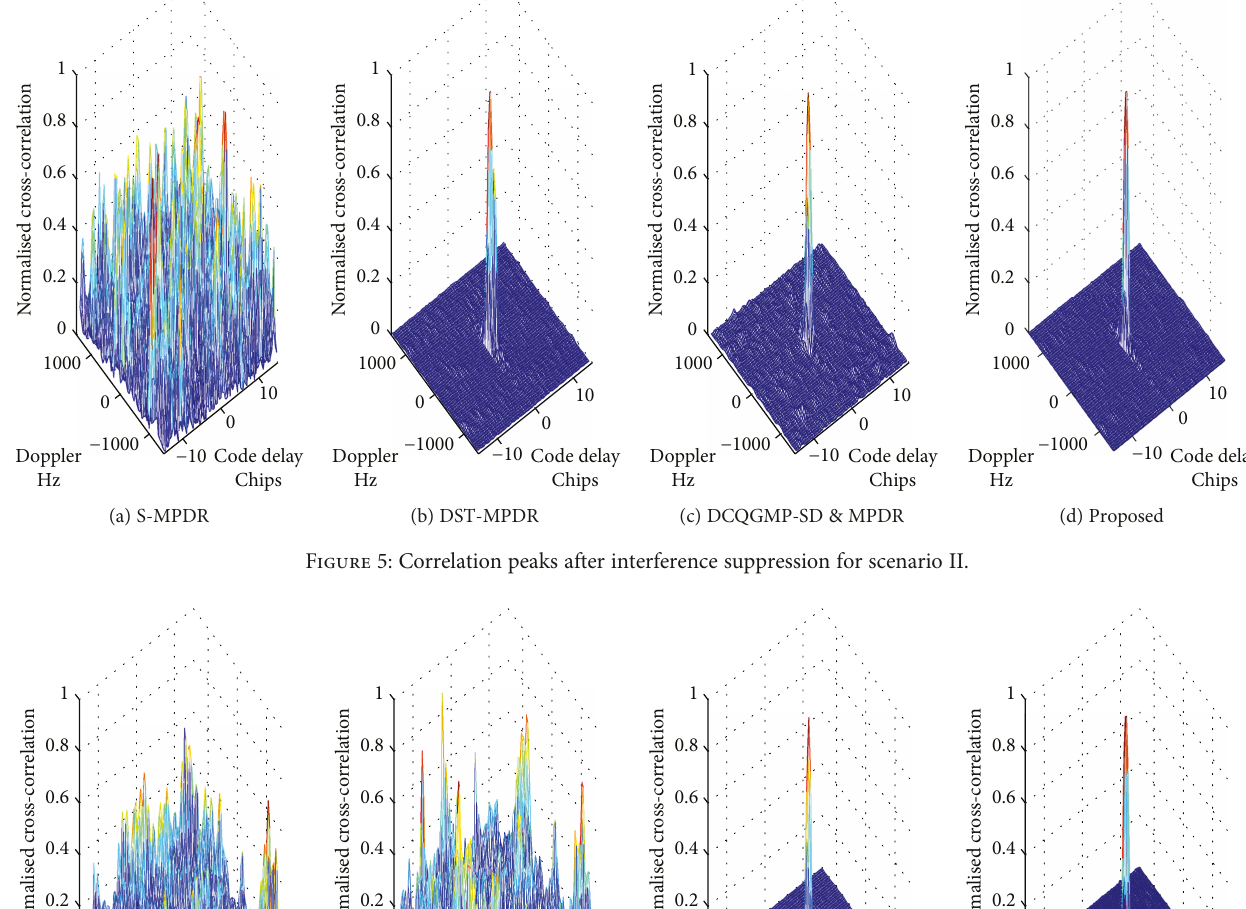
Figure 6: Correlation peaks after interference suppression for scenario III